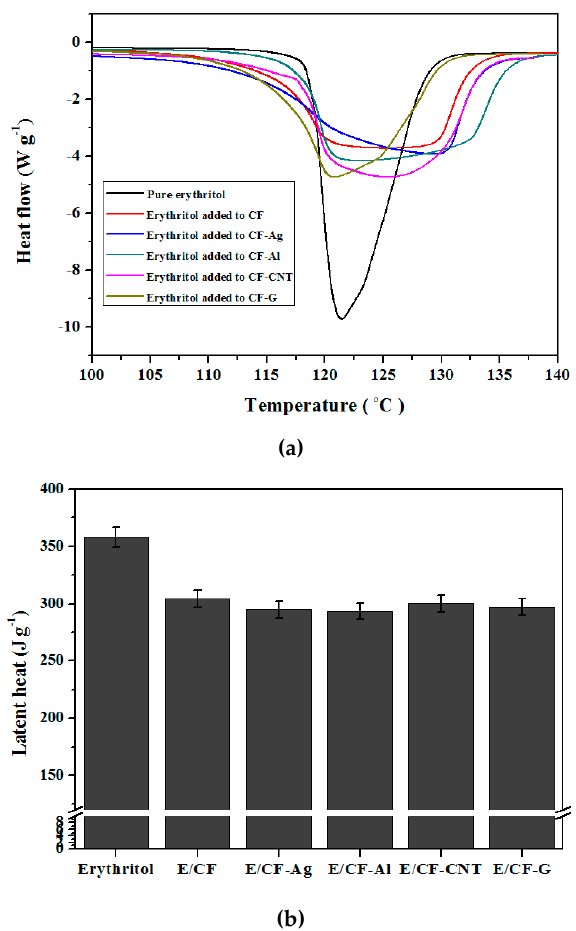
Figure 4. (a) Differential scanning calorimetry (DSC) analysis results and (b) comparison of latent heat values for pure erythritol and erythritol added to the simple CF and CF containing: Ag (CF-Ag); Al (CF-Al); CNT (CF-CNT); and graphene (CF-G).